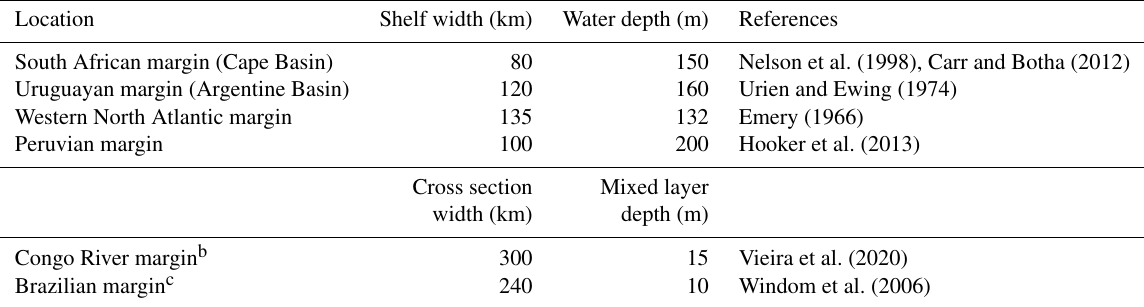
Table D2. Average shelf width and shelf-break water depth for shelf–ocean dTE flux normalisation a .